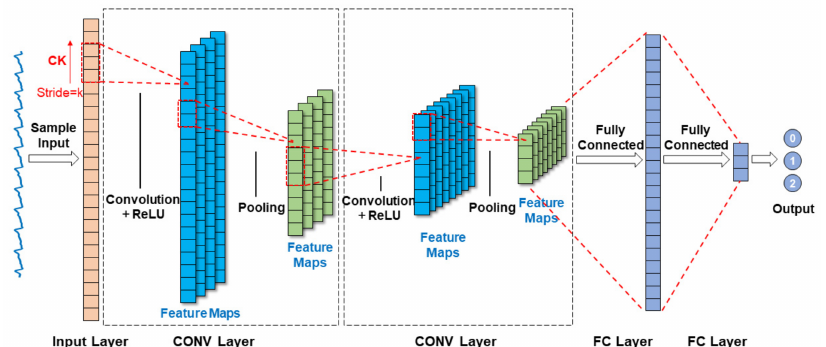
Figure 7. A one-dimensional CNN model.